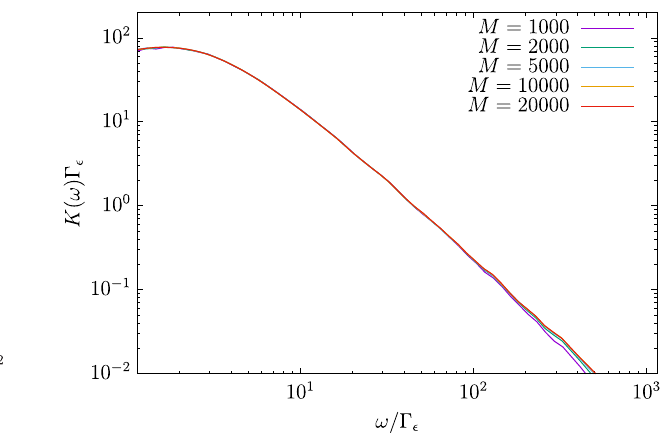
FIG. 23. K ð ω Þ rescaled with the characteristic energy Γ ε ¼ 2 Σ 00 M ε where the typical miniband width is given by Eq. (128). typ Here, γ ¼ 1 with fitting exponent ε ¼ − 0 . 025 .